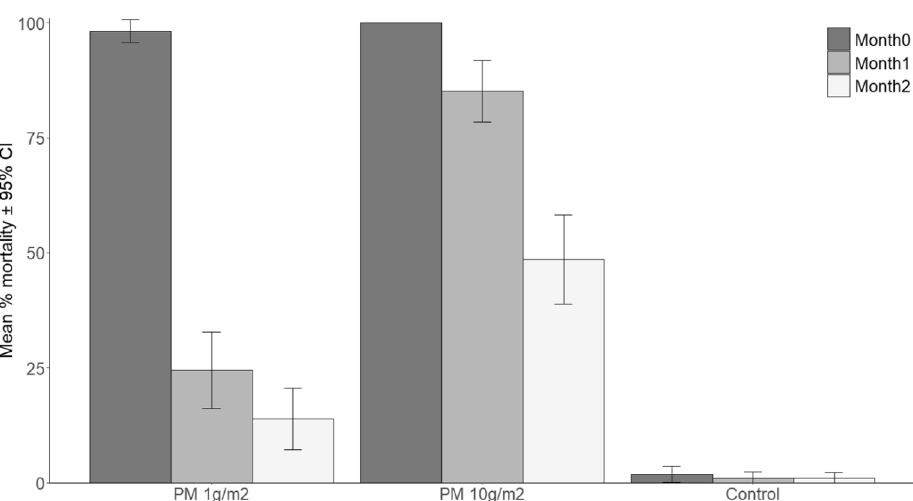
Figure 5. Residual activity in ET bioassays over 2 months of PVC tube coated with pirimiphos methyl at 1 g/m 2 and 10 g/m 2 tested against pyrethroid resistant Anopheles gambiae mosquitoes from Bouaké with 1 h exposure and 24 h recovery. Error bars indicate the 95% confidence intervals.